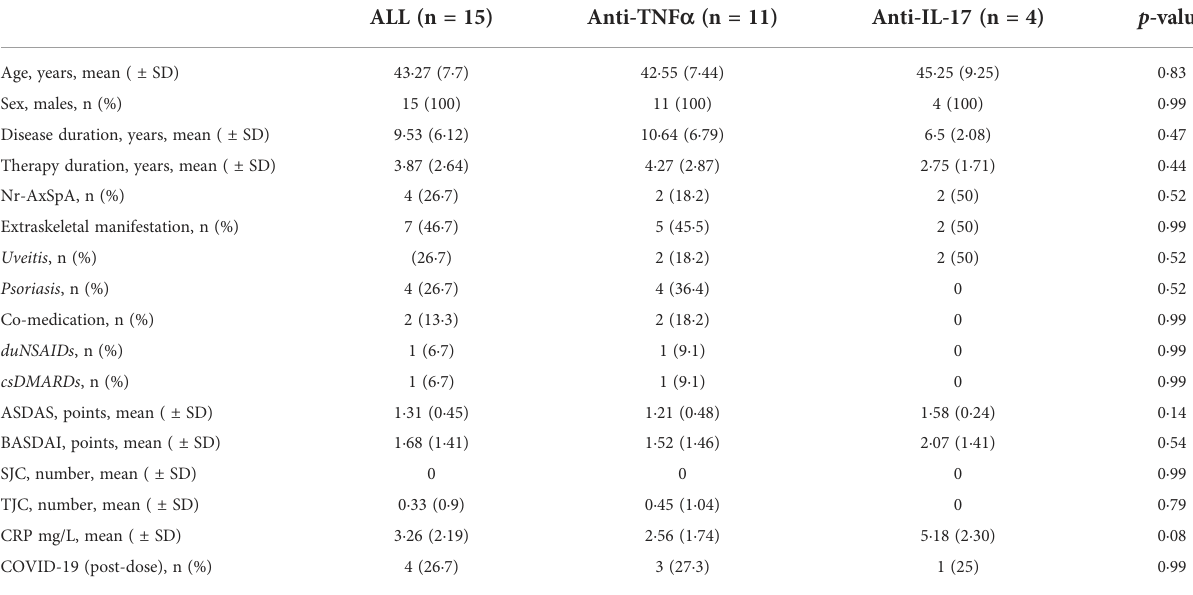
TABLE 1 Baseline characteristics of participants with axial spondyloarthritis